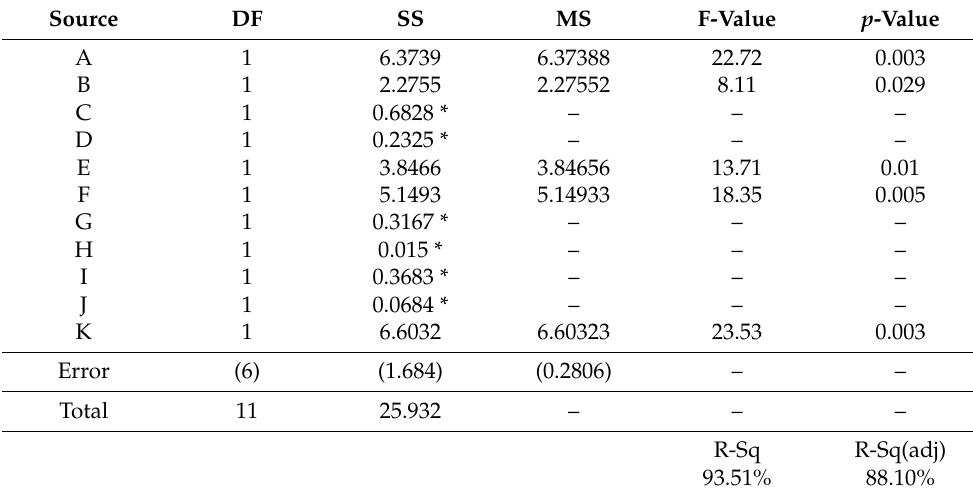
Figure 12. The response graph for the average luminance of the L 12 (2 11 ) experiment. Table 7. ANOVA on values of the average luminance of the L 12 (2 11 )